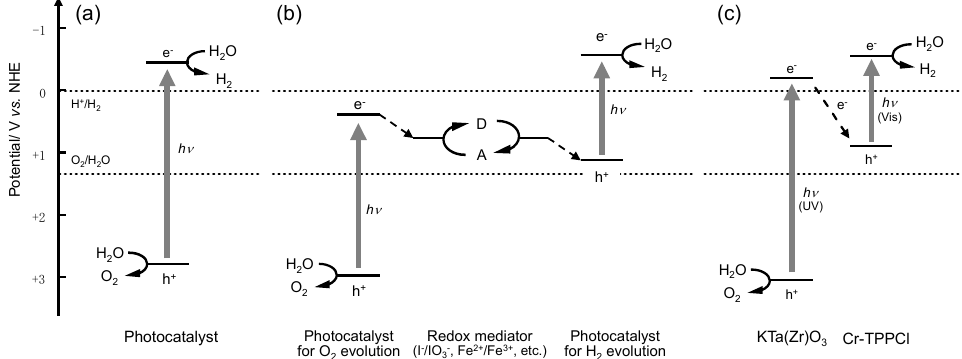
Figure 1. Various heterogeneous photocatalyst systems for water splitting reaction. ( a ) A one ‐ photon system; ( b ) the Z ‐ scheme system; and ( c ) the Cr ‐ TPPCl ‐ modified KTa(Zr)O 3 system.